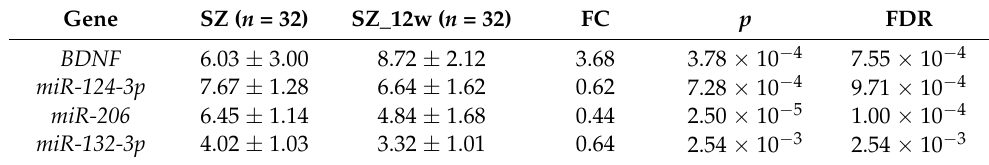
Table 3. Expression levels in SZ patients before and after antipsychotic